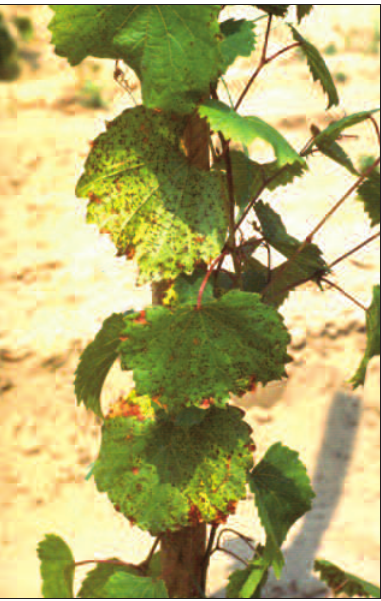
Figure 19. Vein mosaic (GVM) – pale green discolorations along the main veins, producing a feathering or banding effect